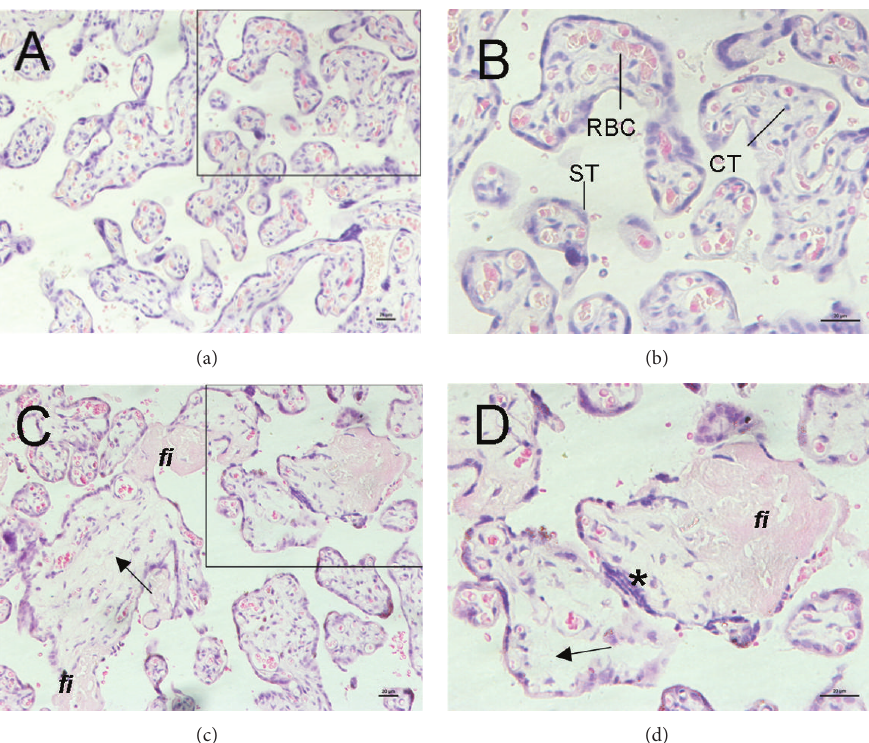
Figure 1: Pathological morphology of placentas from control group (a, b) and GDM group (c, d). Placental sections were HE-stained. (a) The normal branching of villous trees. (b) The syncytiotrophoblast (ST) was clearly observed lying outside the villi, with scarce single cells of cytotrophoblast (CT). (c and d) The increased syncytial knotting ( ∗ ), villous edema (arrows), and perivillous fibrin (fi) depositions in GDM group. Bar = 20